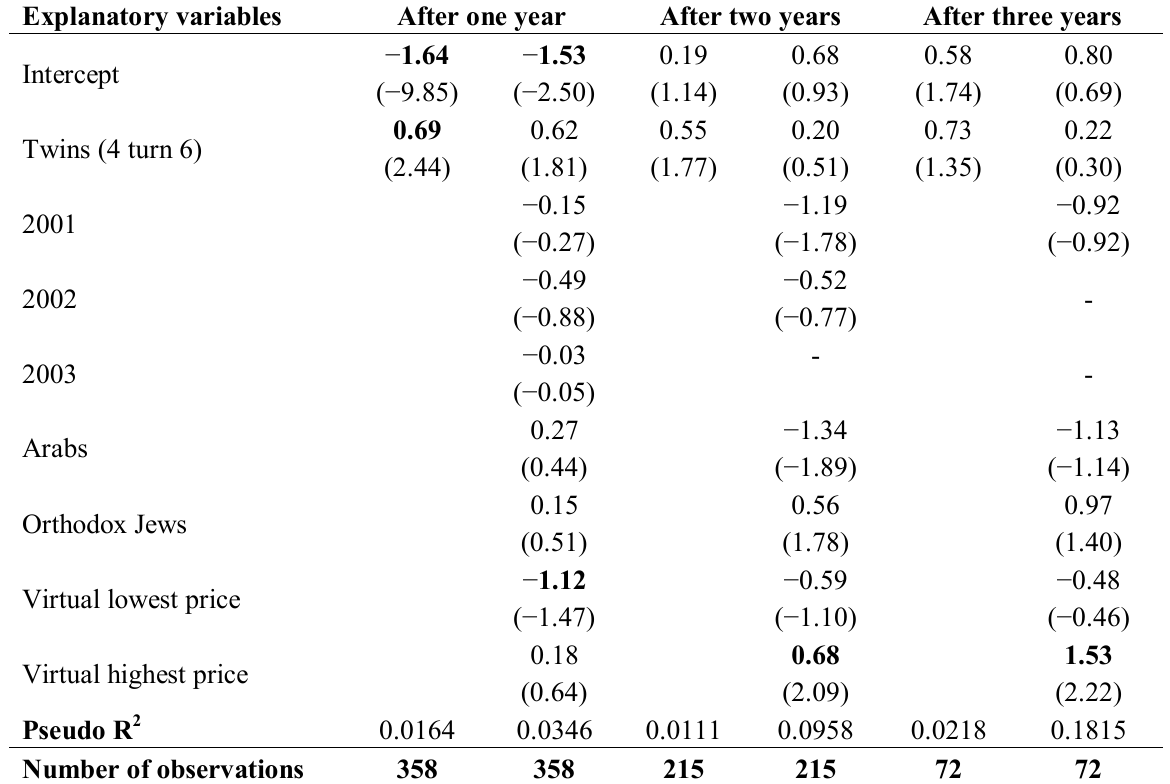
Table 4. Effect of administrative costs on take-up rates: Logit estimation . (Dependent variable: reporting status in year